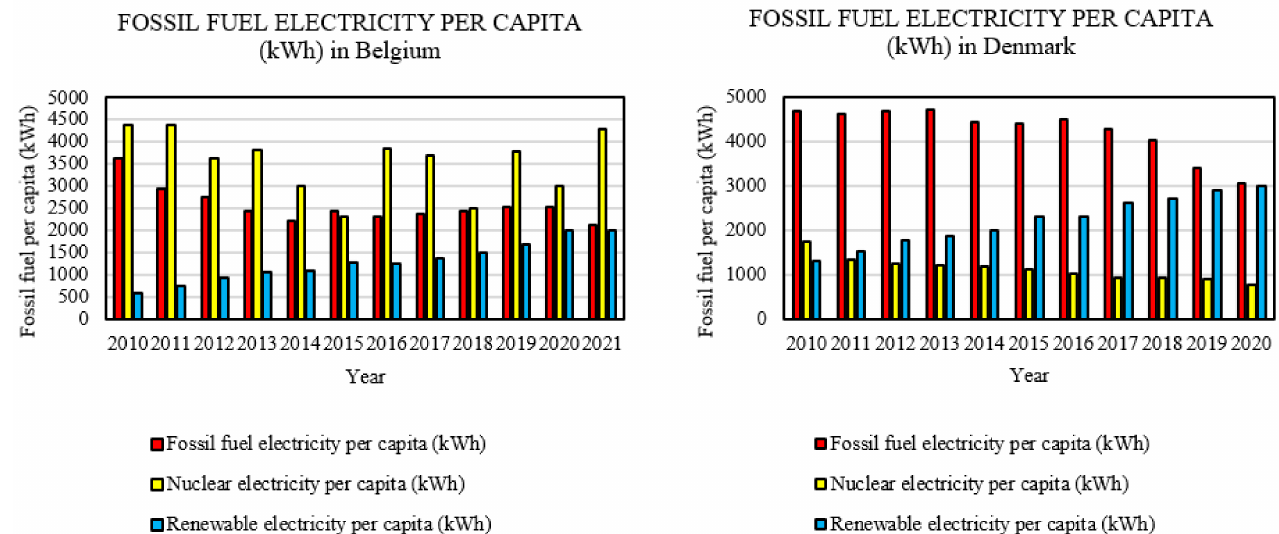
Figure 12. Fossil fuel electricity per capita (kWh) in Belgium and Denmark.